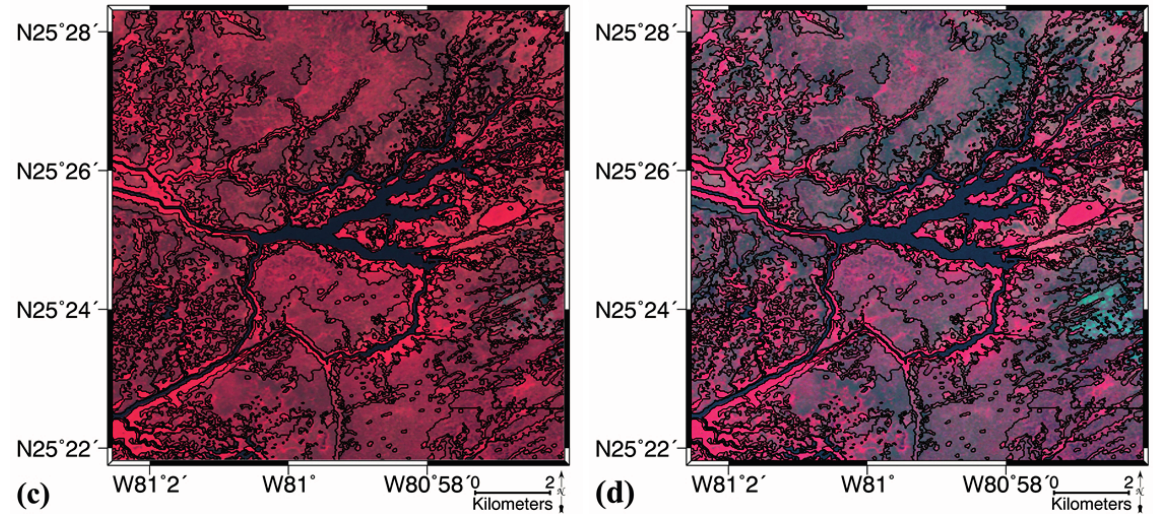
Figure 4. A time series of Landsat TM data rendered as false-color composite images overlaid with the vegetation map created in 1999. ( a ) 1 April 1994; ( b ) 23 April 2008; ( c ) 25 December 2010; ( d ) 10 November 2011. The intensive red color along the tidal channel corresponds well with the mangrove forest, and the color ranges are consistent across the time series.